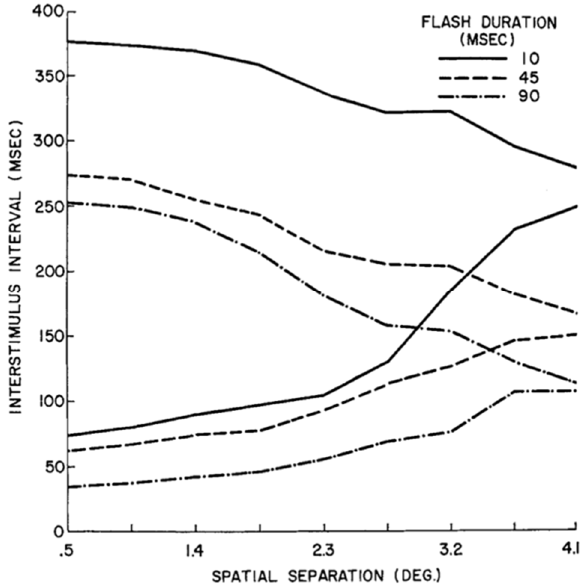
Figure 11. Two spatially separated flashes can be perceived as occurring simultaneously, in apparent motion, or as separate flashes appearing in succession. The figure shows these three distinct percepts as a function of flash spatial ( x -axis) and temporal ( y -axis) separation for three different flash durations. For each duration, simultaneity and succession are perceived below the lower curve and above the upper curve, respectively. Between these two curves, apparent motion is perceived. From Ref. [33] with original data from Ref. [34].